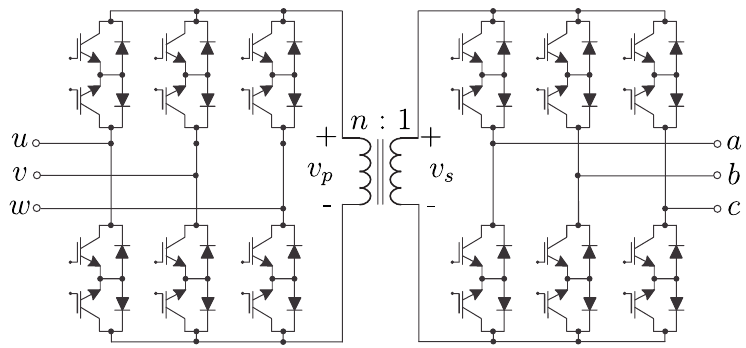
Figure 26. Solid-state-transformer-based matrix converter.